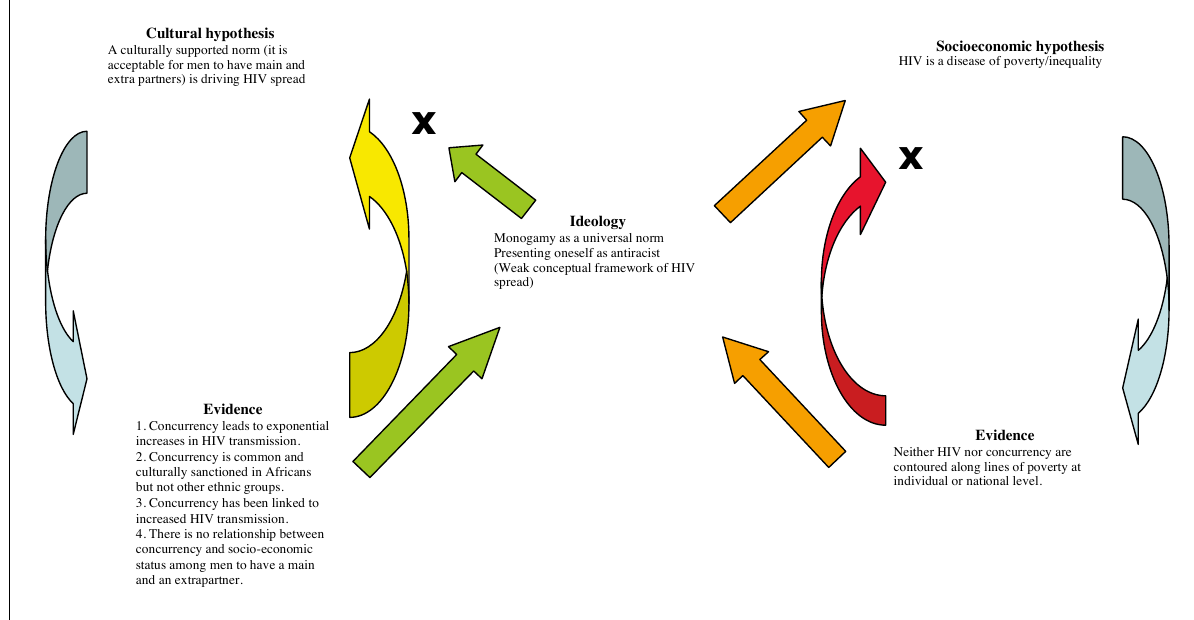
Fig. 1. The cognitive processes involved in evaluating two competing theories for why HIV has spread so extensively in some racial groups in South Africa. As illustrated here, the lack of evidence to support the socio-economic thesis should lead to its dismissal (red arrow), while the validity of the evidence to support the cultural hypothesis should serve to strengthen it as an explanatory cognition (yellow arrow). In the setting of the strong ideologies of class-determinism and monogamy-as-a-universal norm and the anchor cognition of wanting to present oneself as antiracist, however, the cultural thesis generates considerable cognitive dissonance (one is implying that Africans are more likely to engage in unethical behaviour), and the theory is therefore rejected (green arrows). Likewise, if one is sufficiently committed to class as the explanation for differing HIV rates, then the dissonance produced by the lack of evidence to back one’s ideologically determined theory up can be reduced by the selective interpretation of evidence to back it up (orange arrows).